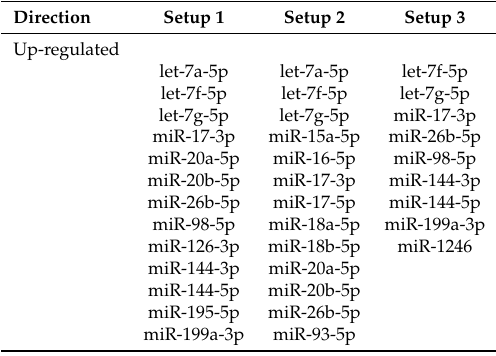
Figure 4. Distribution of Z-scores into six miRNA clusters C 1 – C 6 corresponding to panel ( a – f ), along the four study timepoints using all samples. Each single grey line corresponds to one miRNA expression profile for one participant. Thick black lines display cluster-specific and smoothed curves of a cubic b-spline basis ( b = 3). The distinct clusters contain microRNAs that exhibit similar expression patterns over time. Although every cluster exhibits a wave-like expression pattern, miRNAs in C 1 , C 3 , C 5 show a tendency to be up-regulated after training (up, down, up) while those in C 2 , C 4 , and C 6 tend to be down-regulated after a period of endurance exercise (down, up, down). Table 1. Significantly de-regulated miRNAs that exhibit an absolute log 2 fold change ≥ 1 and a p -value less than 0.05. Results for the three setups correspond to the volcano plots shown in Figure